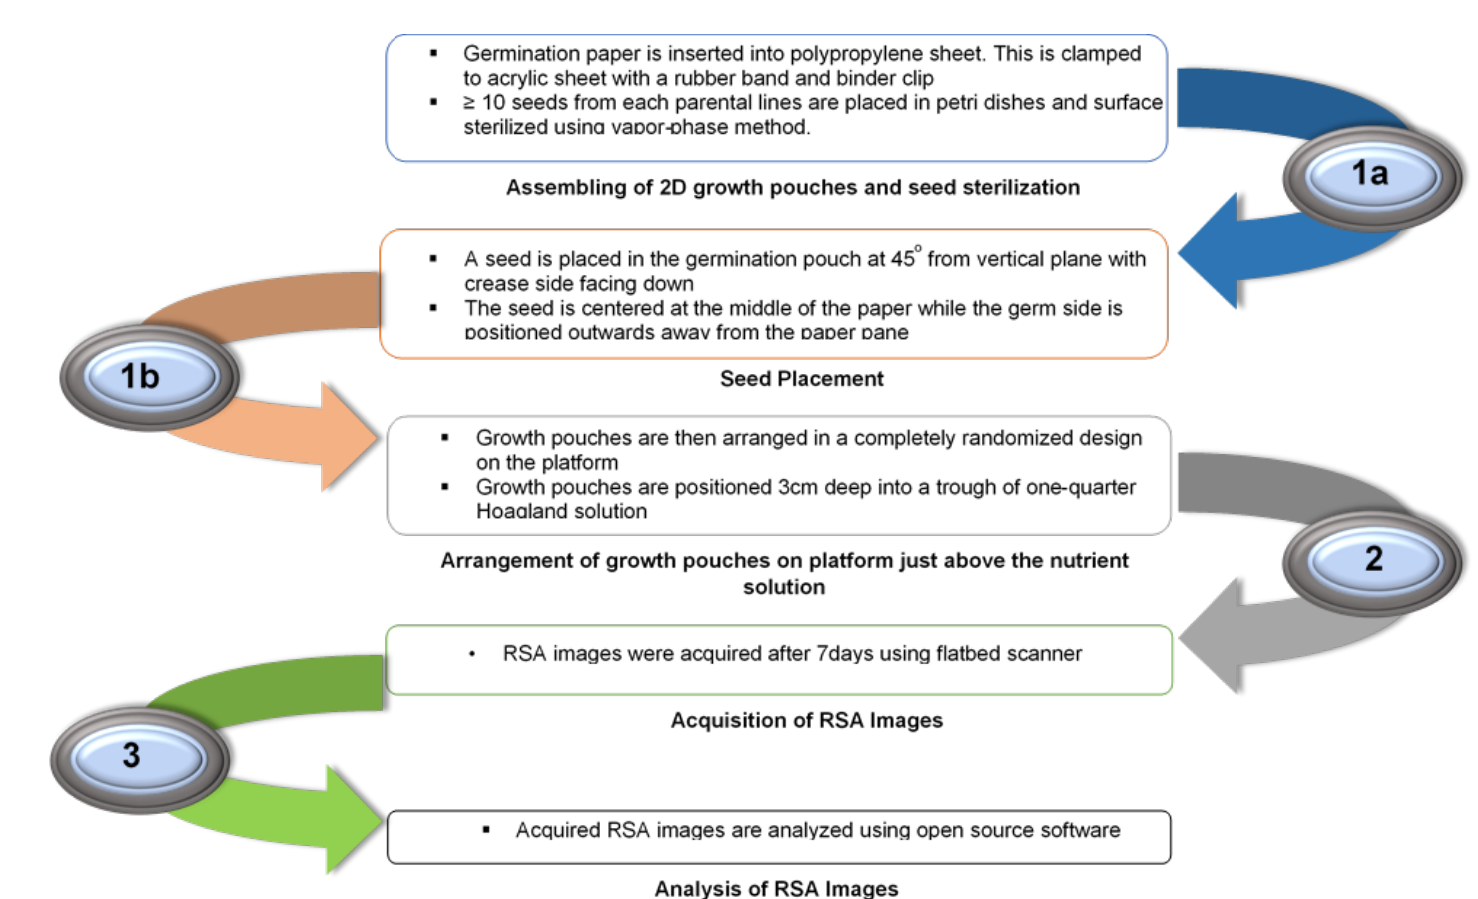
Figure 3. Schematic illustrating the three major steps of the root phenotyping pipeline. The first step is seed sterilization and the assembling of 2D growth pouches (1a), and the placement of seeds in respective pouches accordingly and placement into the tanks (1b). The second step involves the acquisition of RSA images using a flatbed scanner (2). The third step is the analyses of RSA images acquired in the second step (3).